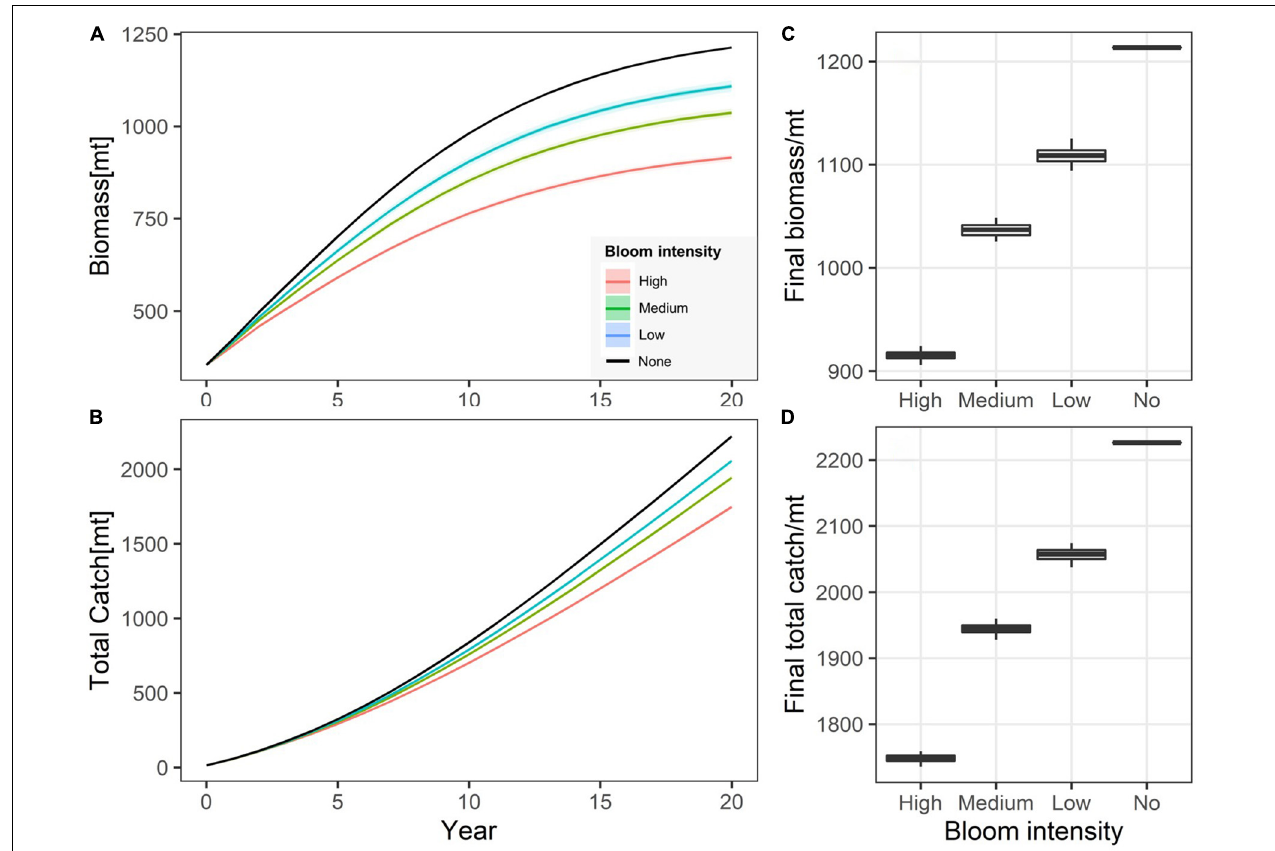
FIGURE 5 | Simulated biomass (A) and total catch (B) trajectories under different green tide bloom intensities. The distributions of the final biomass (C) and total catch (D) are also